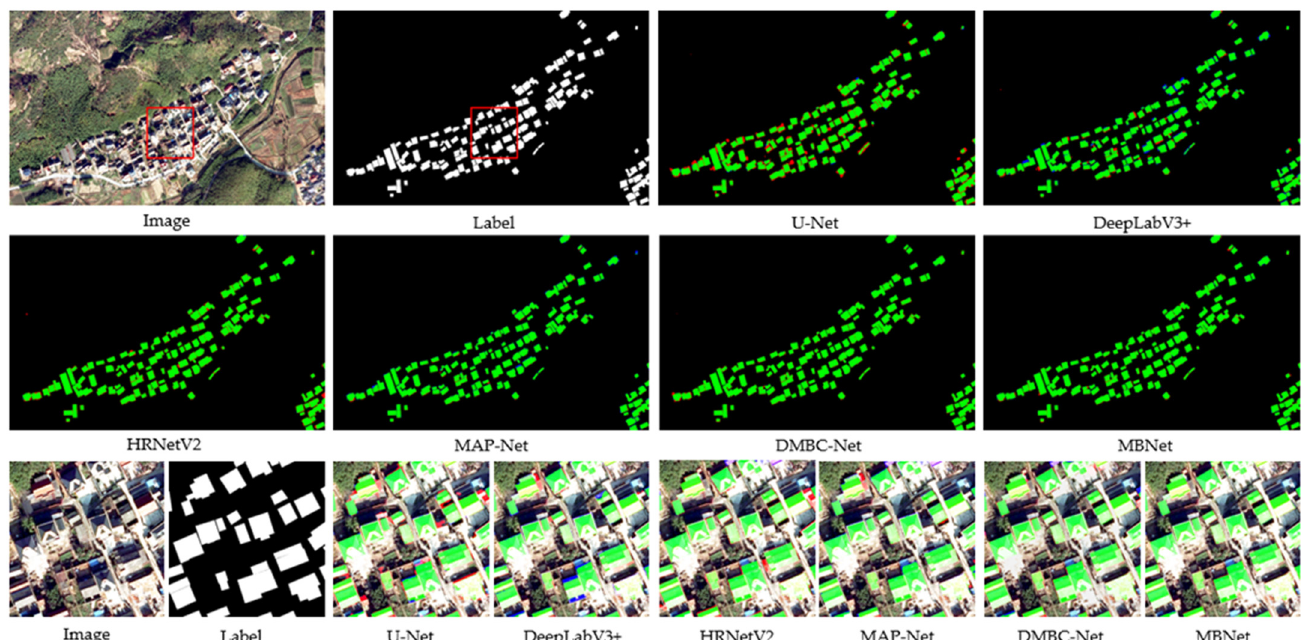
Figure 6. Segmentation results of the different SOTA methods on the mountain landform scene 1 test dataset. The bottom row is a close-up view of the red box.